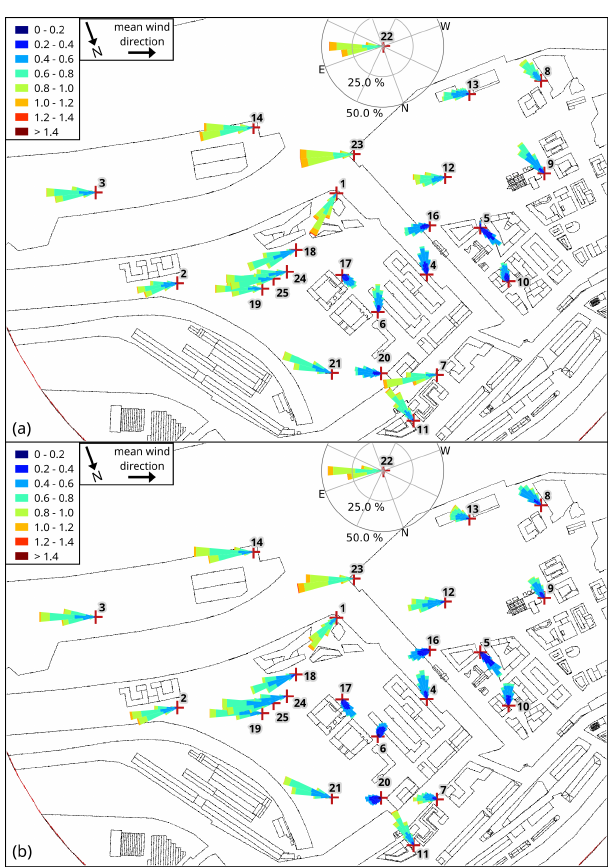
Figure 9. Wind-speed distribution (wind rose plots) at all measure- ment stations for (a) wind-tunnel measurements and (b) the PALM simulation at about 10m height above street level (wind tunnel: 10m, PALM: 9 . 5m). Axes are only shown for a single station for better overview, but all wind distributions are scaled equal. Num- bers indicate the station